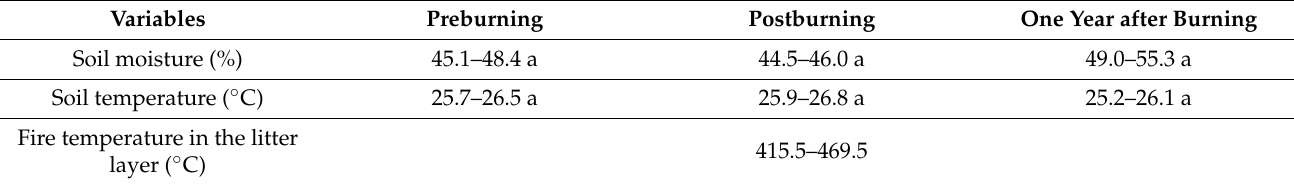
Table 1. Soil moisture and soil, air, and fire temperatures at the study sites (minimum–maximum).